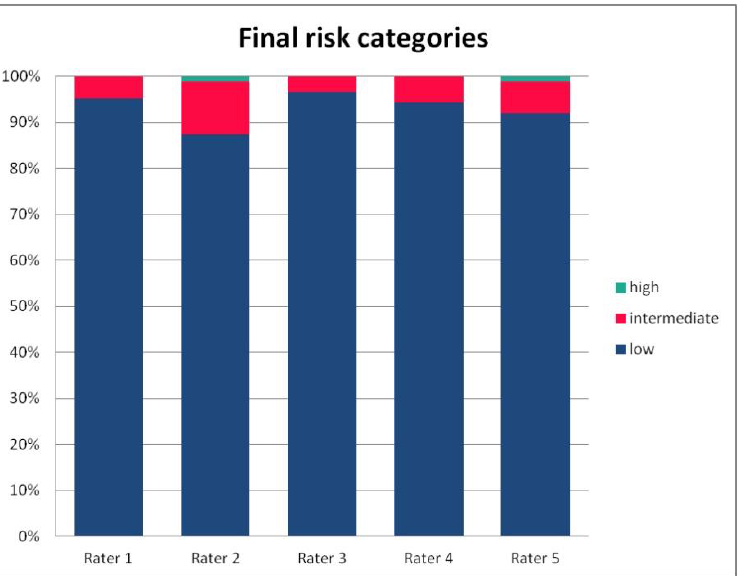
Figure 5. The percentage of risk categories of the PRAETORIAN score, calculated for the patients on the basis of ratings given by individual raters.